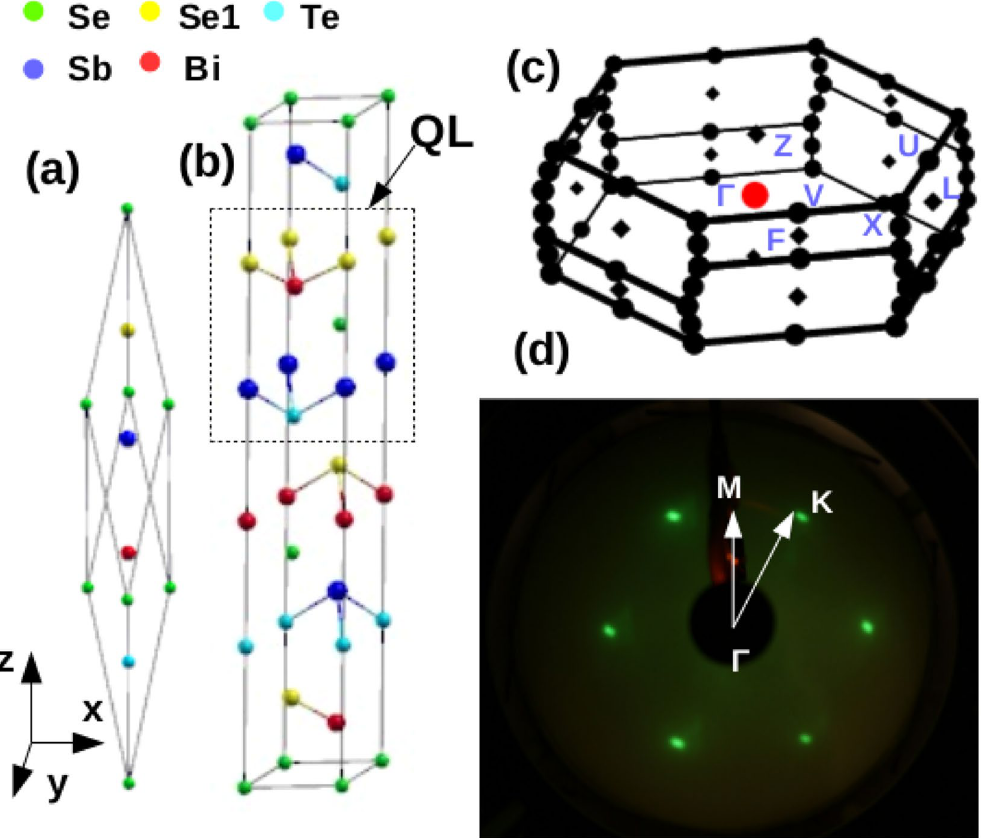
Figure 1. ( a and b ) show the primitive and hexagonal unit cells of BiSbTeSe 2 respectively. The dotted box encloses the structure of five atomic layers which is called quintuple layer (QL). ( c ) Brillouin zone of the primitive unit cell where high symmetry k-points are marked. ( e ) LEED spots depict the hexagonal symmetry of the surface BZ of BSTS where the high symmetry k-directions Γ -K and Γ -M are